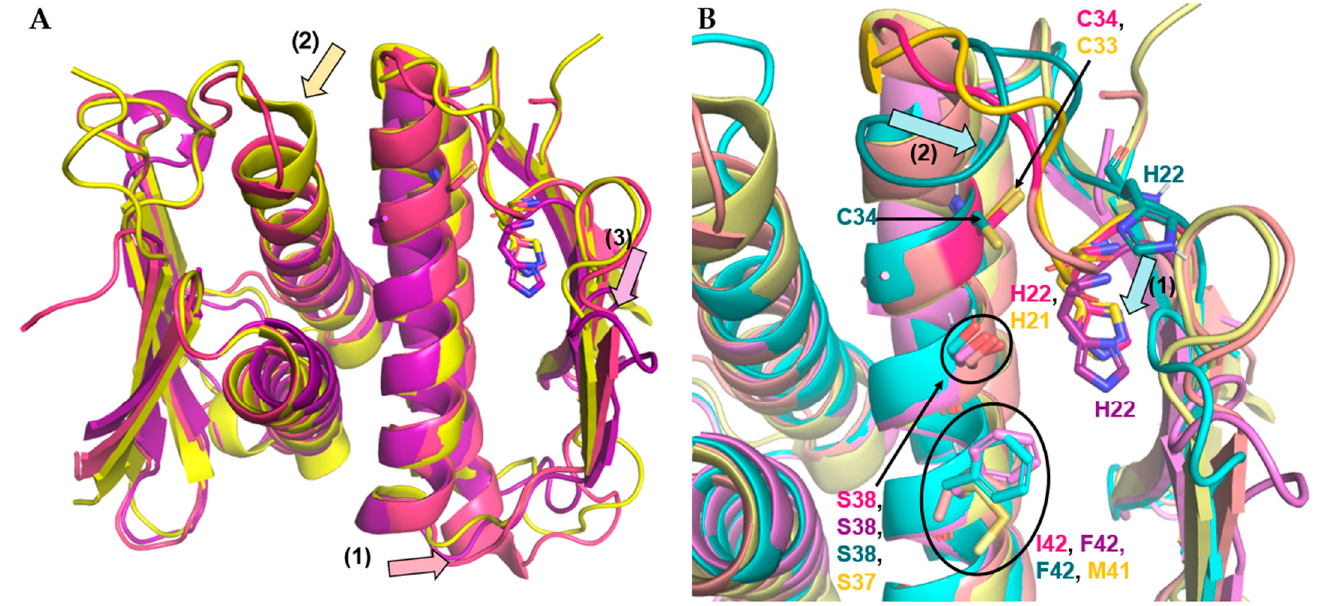
Figure 7. Firmicute Prp structures. ( A ). Unbound Firmicute Prp crystals overlaid. Sa Prp (4PEO) in violet, Smu Prp (2IDL) in pink, and Sp Prp (2G0I) in yellow. Significant changes indicated by arrows and catalytic residues shown as stick representations. ( B ). Binding site of all known Firmicute Prp structures, unbound Sa Prp, Smu Prp, and Sp Prp and bound Sa Prp (7KLD, cyan). Flexible loop and catalytic residues in darker corresponding colors. Movement attributed to binding indicated by blue arrows (1 and 2). All images produced with PyMOL Molecular Graphics System, Version 2.0